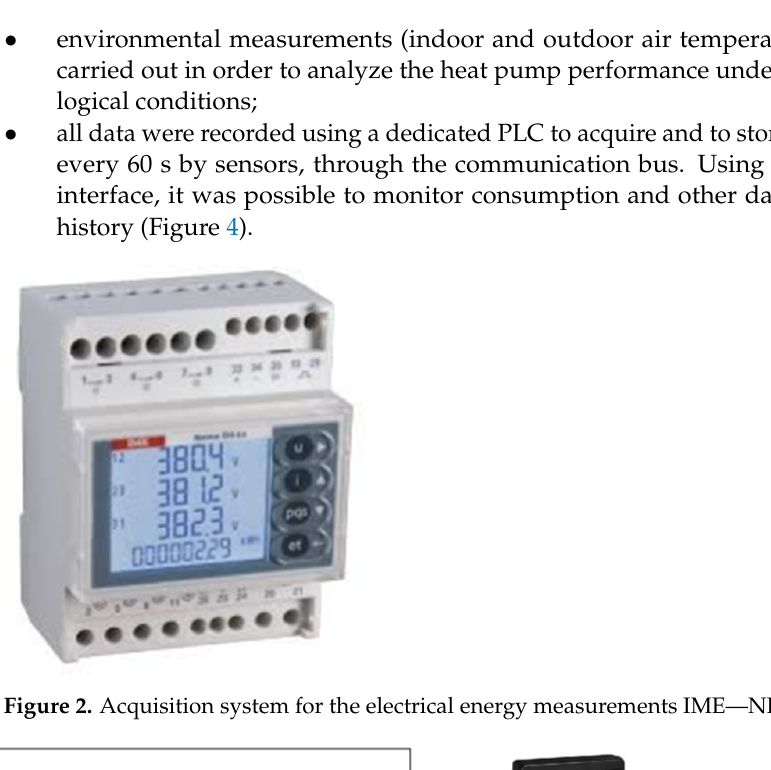
Figure 3. Drawing of the acquisition system for thermal energy Caleffi—Conteca Easy—Ultra.